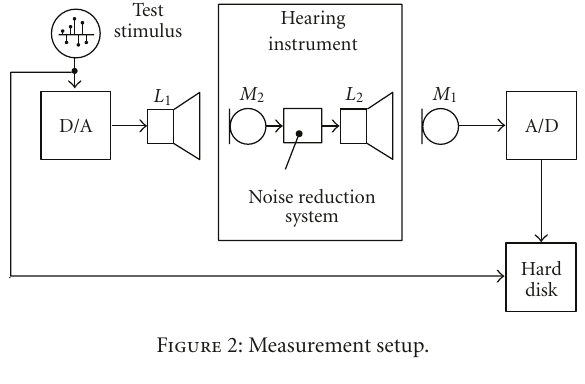
Figure 2: Measurement setup.